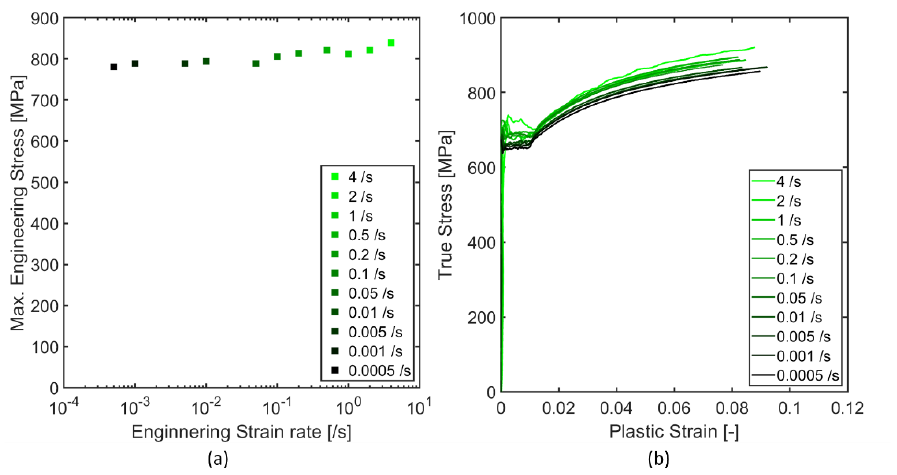
Fig. 3. (a) UTS plotted as a function of engineering strain rate. Note the monotonic trend of UTS as a function of strain rate. (b) True stress-plastic strain curves from uniaxial tensile experiments on DP800 at various strain